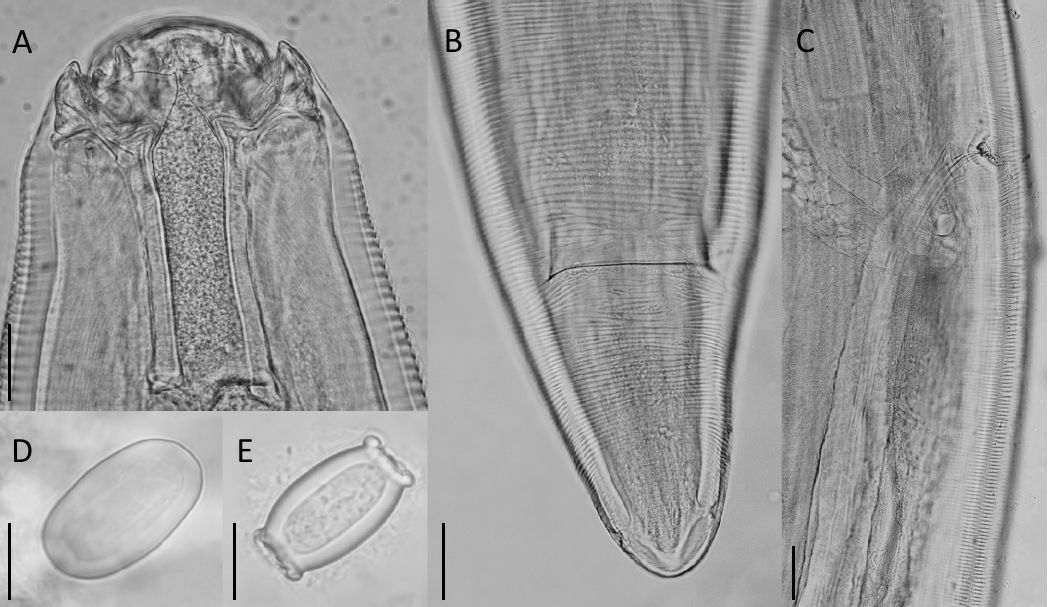
Figure 2. Gendrespirura cf. zschokkei collected from Manis javanica . Female specimens. ( A ) Anterior end, showing teeth on lateral lips and chitinised vestibule, median view. ( B ) Posterior end, showing anus and caudal papillae, ventral view; note striated cuticle. ( C ) Vulva opening with vagina running posteriorly, lateral view. ( D ) Immature egg, dissected from uterus. ( E ) Mature egg, showing char- acteristic barrel-shape, dissected from uterus. Scale bars: ( A ) 50 µm. ( B ) 50 µm. ( C ) 100 µm. ( D ) 20 µm. ( E ) 20 µm. General. Body stout, medium-sized. Cuticle faintly transversely striated along entire body length (Figure 2B). Lateral alae absent. Cephalic region (Figure 2A) with two large lateral pseudolabia, each with three teeth on inner surface; central tooth more prominent than lateral teeth; two small lips; single pair subventral amphids. Buccal capsule cylindri- cal, well-developed, strongly chitinised. Oesophagus long, with shorter narrow muscular portion and longer wider glandular portion. Cervical papillae anterior to nerve ring; ex- cretory pore posterior to nerve ring.